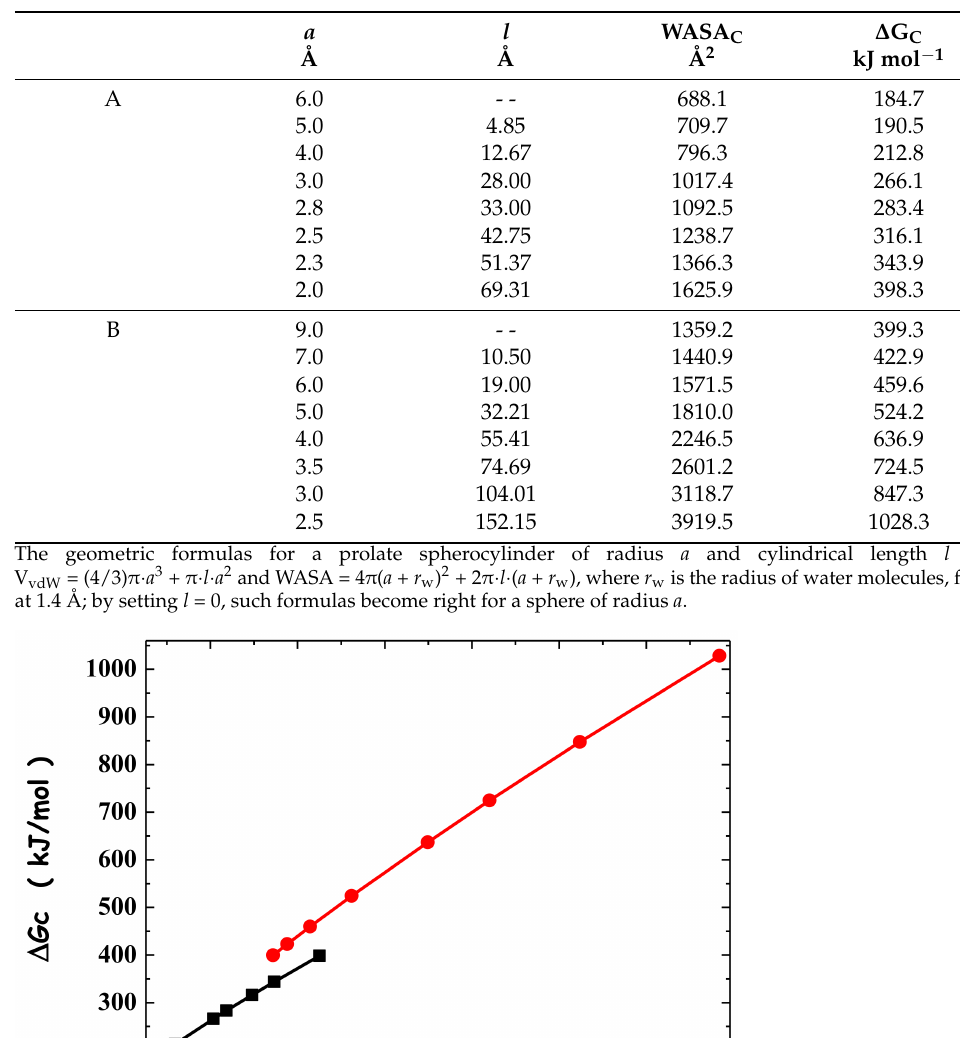
Table 3. ∆ G C estimates associated with the creation of prolate spherocylindrical cavities, at 25 ◦ C and 1 atm, in a hard sphere fluid, with the experimental density of water and particle diameter σ = 2.8 Å. By keeping the cavity V vdW fixed at the volume of 6 Å and 9 Å radius spheres, respectively (i.e., 904.8 Å 3 and 3053.6 Å 3 , respectively), the ∆ G C numbers have been calculated on varying the cylindrical length by means of the classic SPT analytic formulas. The first row of the A and B sections contains the numbers for the two spherical cavities.